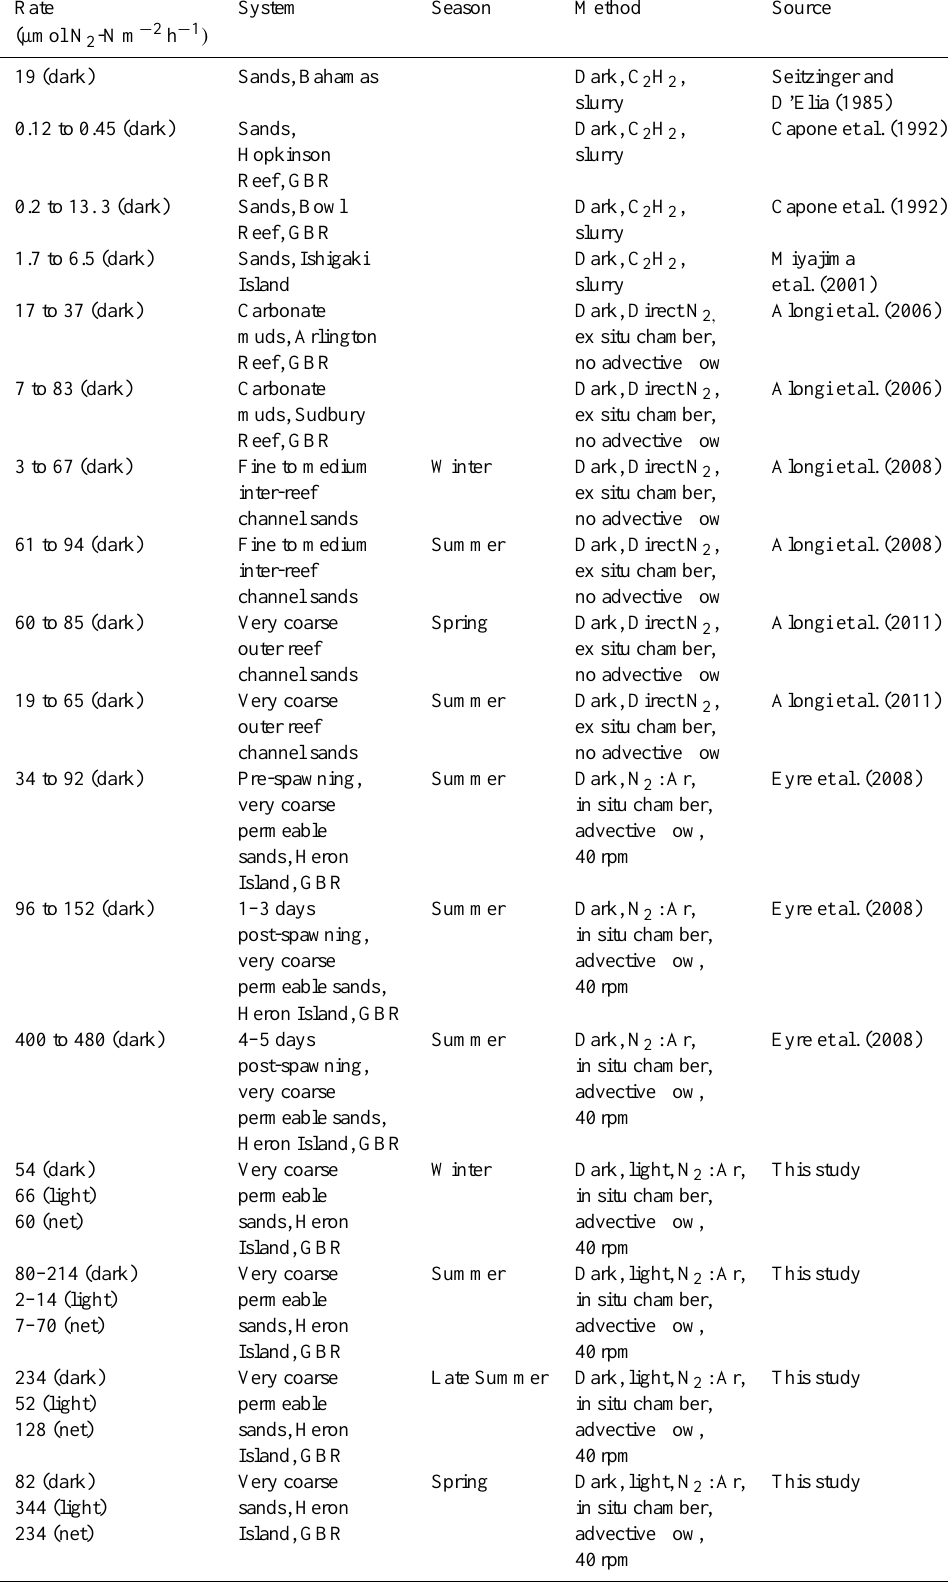
Table 4. Denitrification rates in carbonate